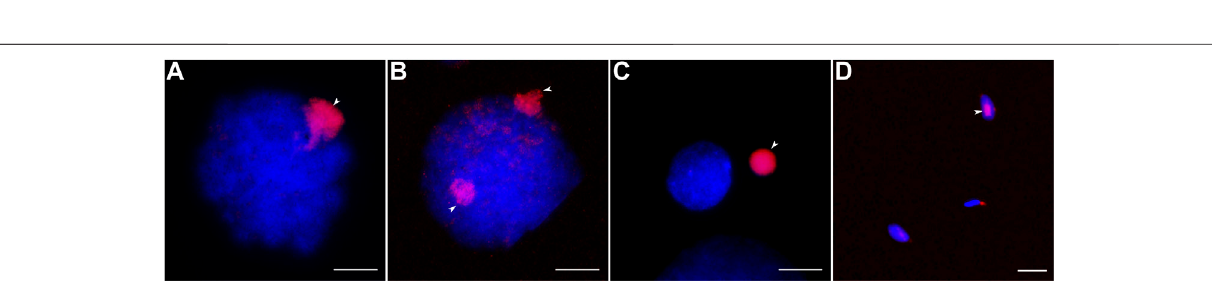
Frontiers in Genetics |